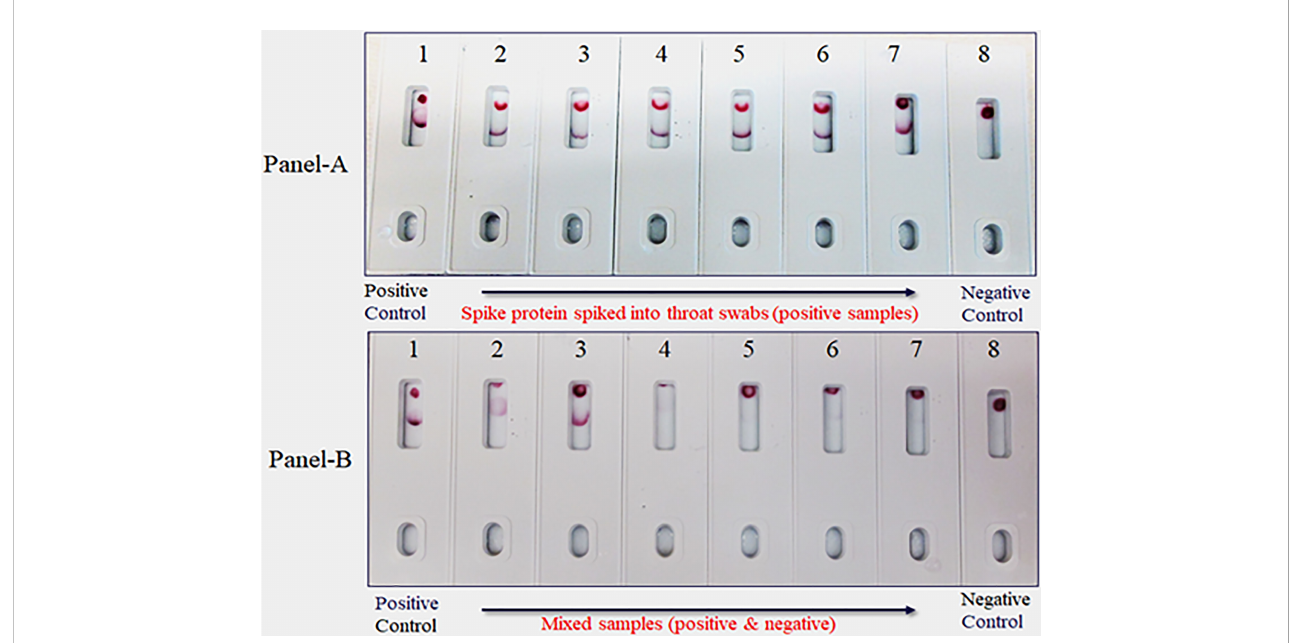
FIGURE 12 Covid-19 recombinant Spike protein spiked into Vero cell lysate and absorbed with swabs to mimic clinical samples and tested. The “ Swab Mimicking Test ” experiment was designed to test simultaneously spiking recombinant spike protein into Vero E6 cell lysate, absorbed, and extracted for test. Panel A: all positive samples, and Panel B: mixed both positive (1 to 3) and negative samples (4 to